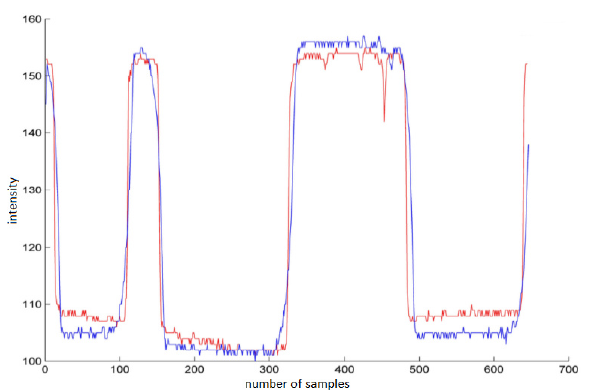
Figure 13. Correlation of two intensity signals (reference red, actual blue) on one circle